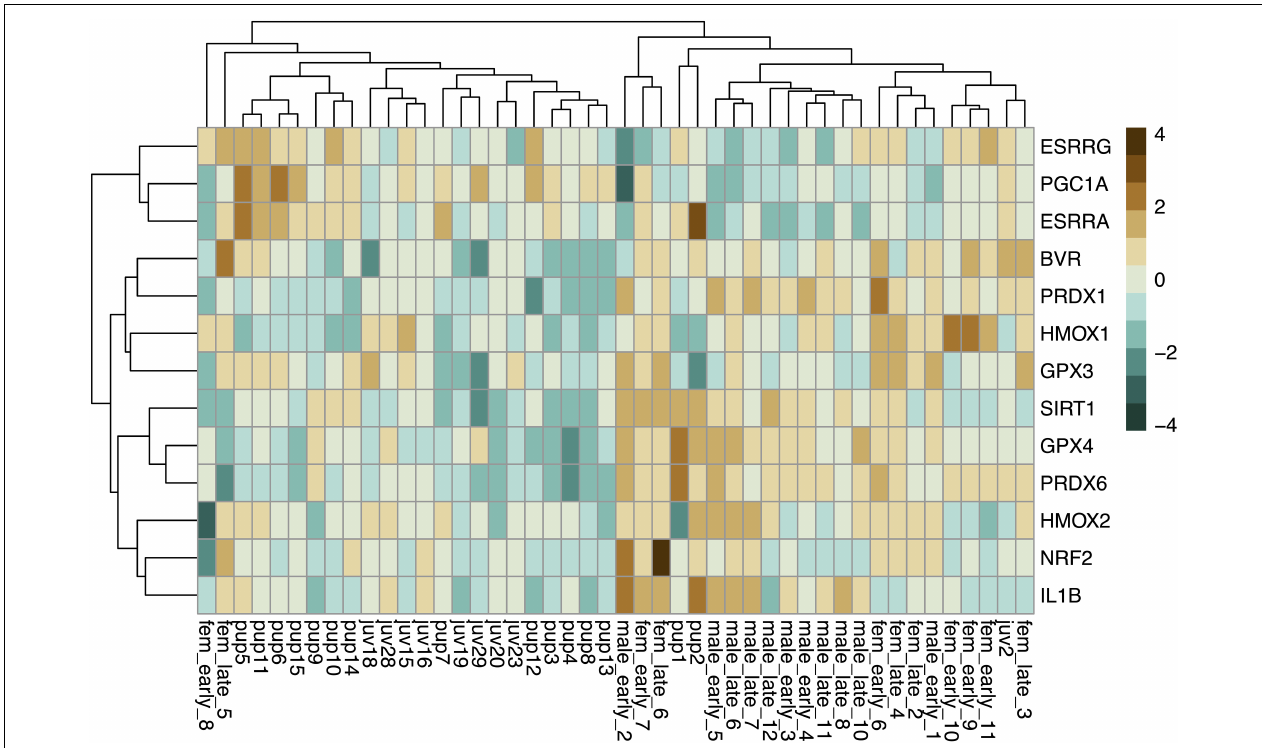
FIGURE 2 | Heatmap showing scaled baseline expression (delta C T ; higher: brown, lower: blue) of 13 genes (rows) associated with CO signaling and cytoprotection in skeletal muscle of NES pups ( n = 15), juveniles ( n = 9), and adults ( n = 22; columns). Rows and columns were clustered by Euclidean distance.